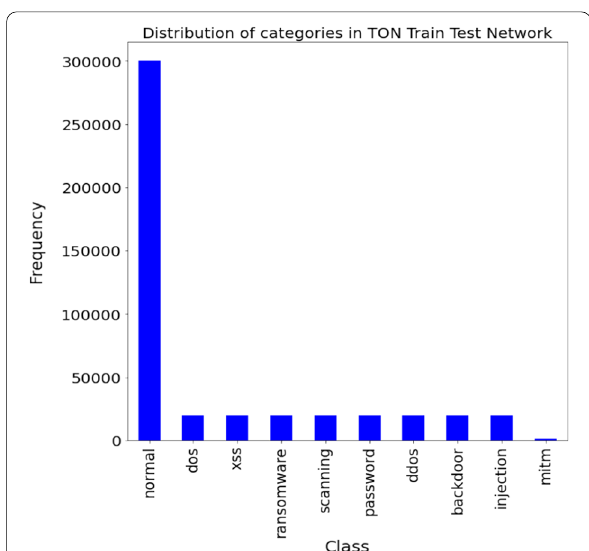
Fig. 6 Distribution of categories in TON_Train_Test Network